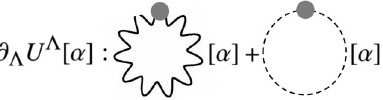
FIG. 5. Graphical representation of the flow equation [Eq. (4)] involving traces over field ( α )-dependent Goldstone (wiggly loop) and longitudinal (dashed loop) propagators, respectively. Gray dots denote cutoff our calculations at constant chemical potentials (using their difference as the tuning parameter).